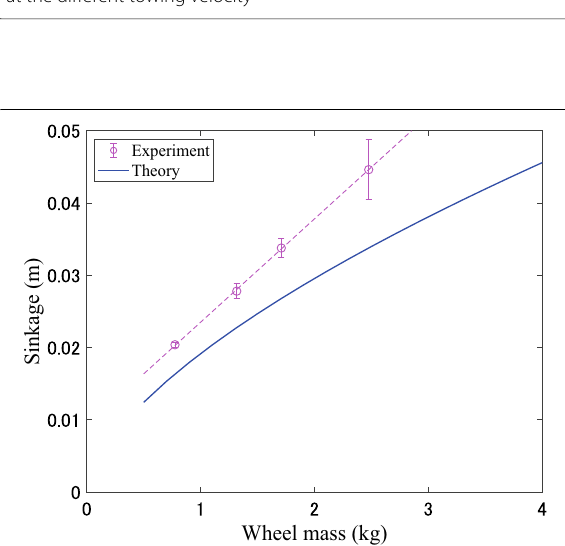
SD steady-state sinkage at different wheel mass. Fig. 12 Mean ± Diameter 0.17 m; width 0.04